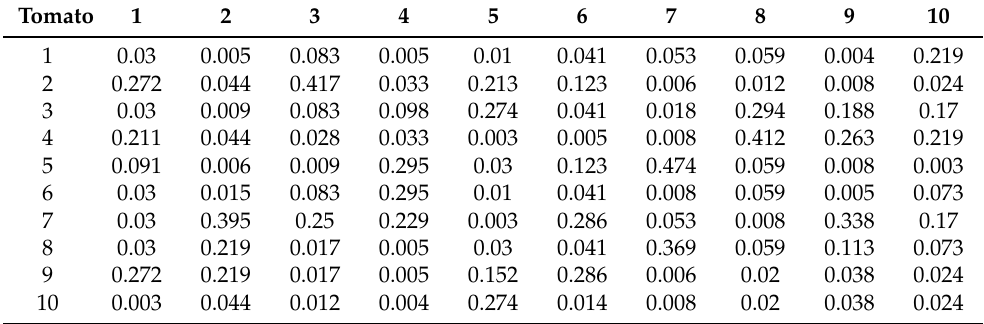
Table A31. Normalization matrix of tomato.